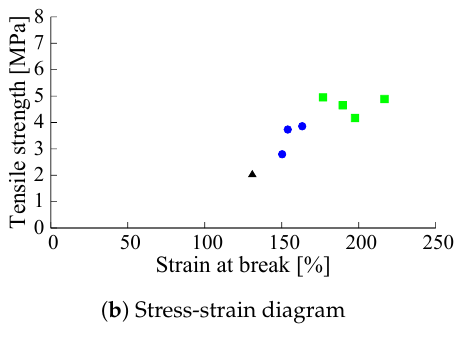
( b ) Stress-strain diagram